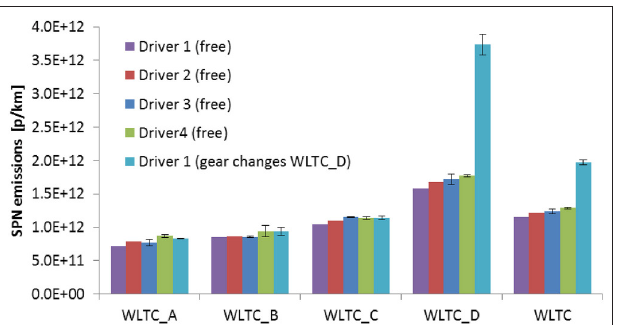
FIGURE 7 | Effect of driving style on the SPN emissions of Vehicle GDI #3. Error bars indicate the minimum and maximum SPN emissions of two test repetitions conducted with 3 months difference between them. All drivers were free to choose their gear shifting, except Driver 1 who followed in one test sequence of WLTC_D a gear shift strategy at higher rpm. Tests in the laboratory were conducted with PMP-CVS equipment.